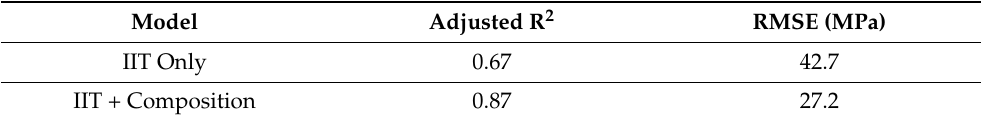
Table 2. Comparison of metrics for the YS